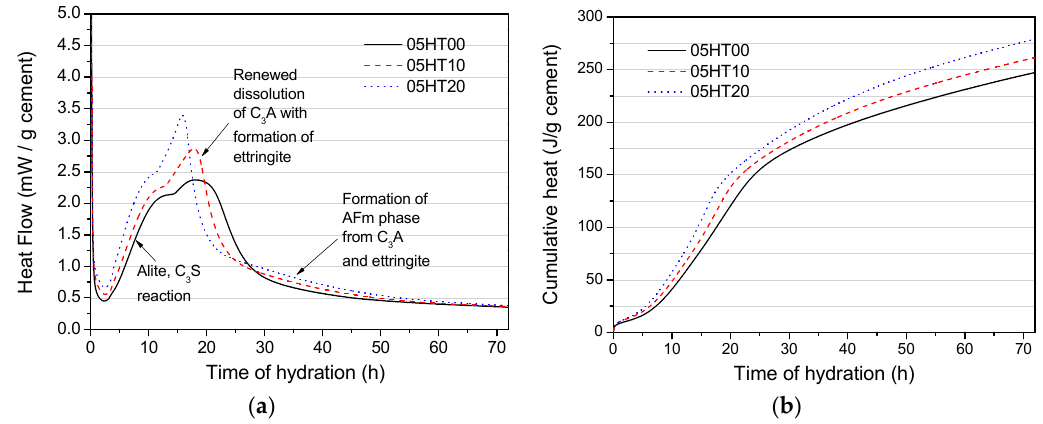
Figure 6. Hydration heat evolution for samples with w/b = 0.5. ( a ) Heat flow and ( b ) cumulative heat.